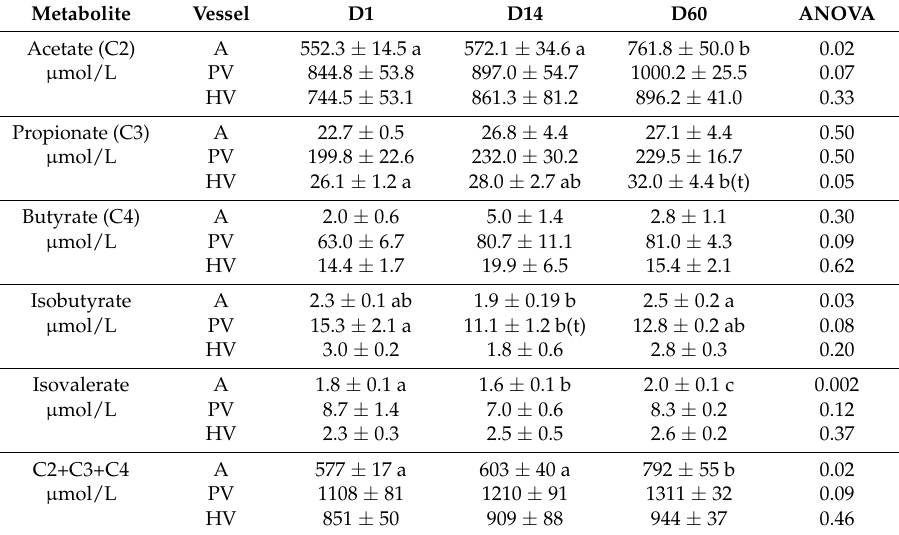
Table 2. Acetate (C2), propionate (C3), butyrate (C4), isobutyrate, isovalerate and C2+C3+C4 concentrations in the fasted state in artery (A), portal vein (PV), and hepatic vein (HV) before (D1) and after 14 days (D14) and 60 days (D60) of adaptation to HFHS